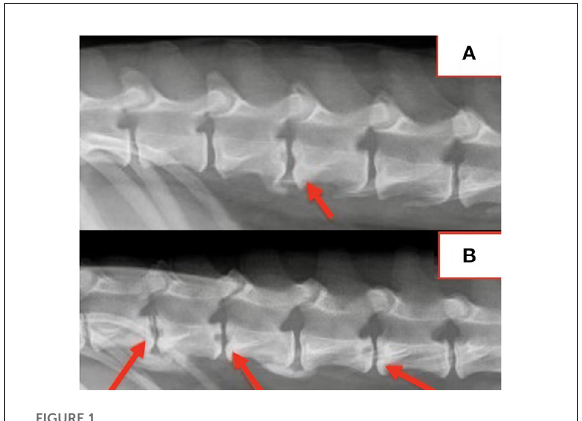
FIGURE1 (A,B) Lateral radiographs exemplifying typical “hole punch” lesions (red